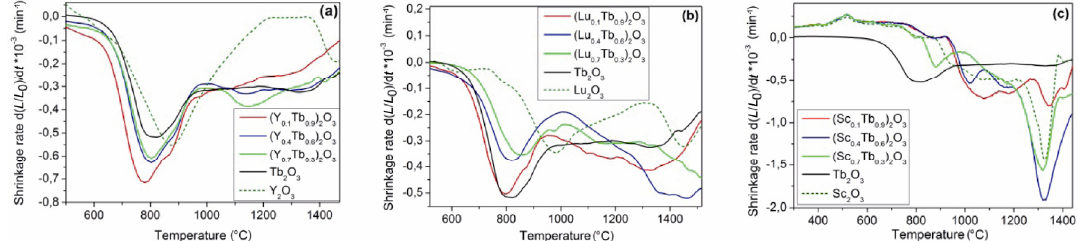
Fig. 3 Shrinkage rate curves of SHS powder compacts of terbia and compounds of terbia with (a) yttria, (b) lutetia, and (c)